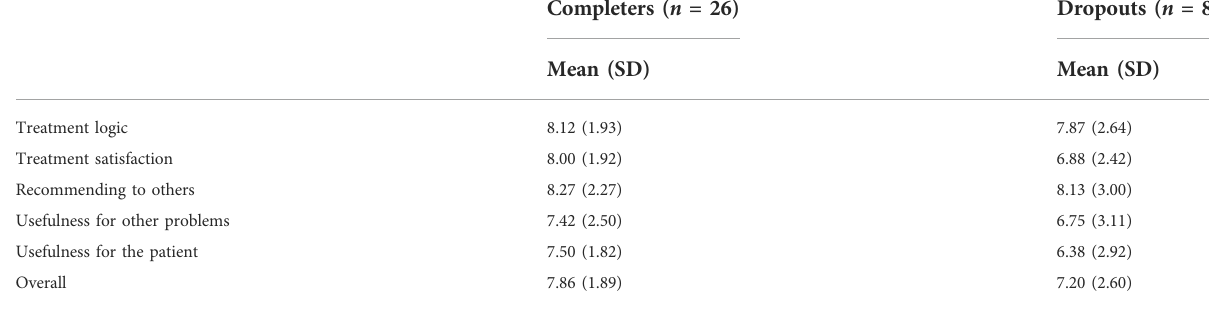
TABLE 4 Mean and standard deviations on Treatment Expectation Scale a for completers and dropouts.